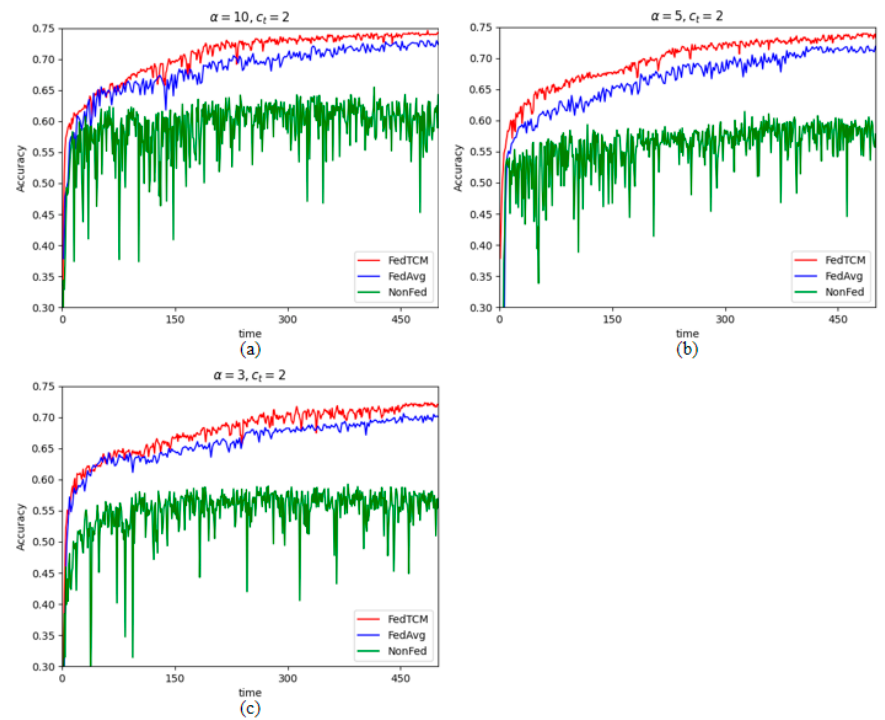
Figure 8. Comparing FedTCM with the baseline algorithms on the sports behavior dataset at 𝑐 (cid:3047) = 2 . ( a ) FedTCM and baseline algorithms are all set 𝛼 = 10 . ( b ) FedTCM and baseline algorithms are all ( a ) FedTCM and baseline algorithms are all set α = 10. ( b ) FedTCM and baseline algorithms are all set 𝛼 = 5 . ( c ) FedTCM and baseline algorithms are all set 𝛼 = 3 . set α = 5. ( c ) FedTCM and baseline algorithms are all set α =